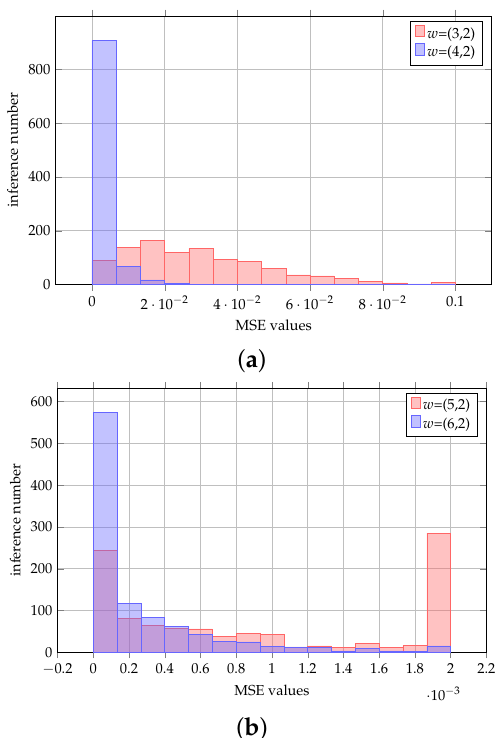
Figure 12. Histograms for the MSE values for various data wordlengths for the case of 1000 inferences in the VGG-16 CNN. ( a ) Histograms for the MSE values for (3, 2) and (4, 2) data wordlength. ( b ) Histograms for the MSE values for (5, 2) and (6, 2) data